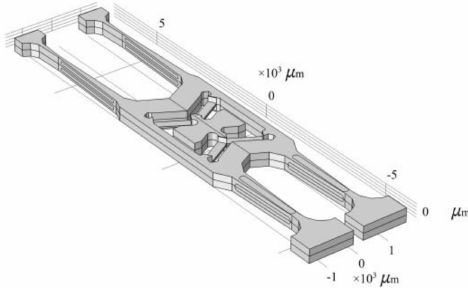
Figure 9. The quartz tuning forks resonant structure.